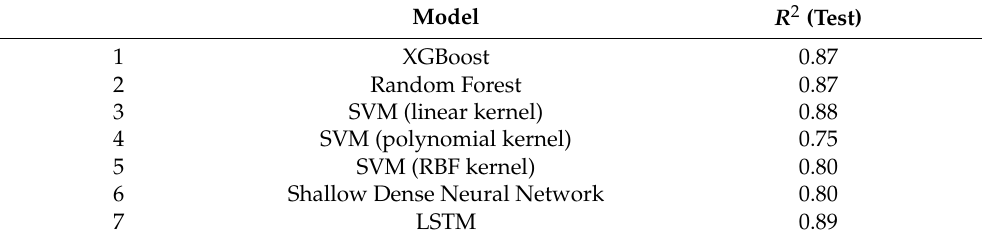
Table 3. Comparison of models.